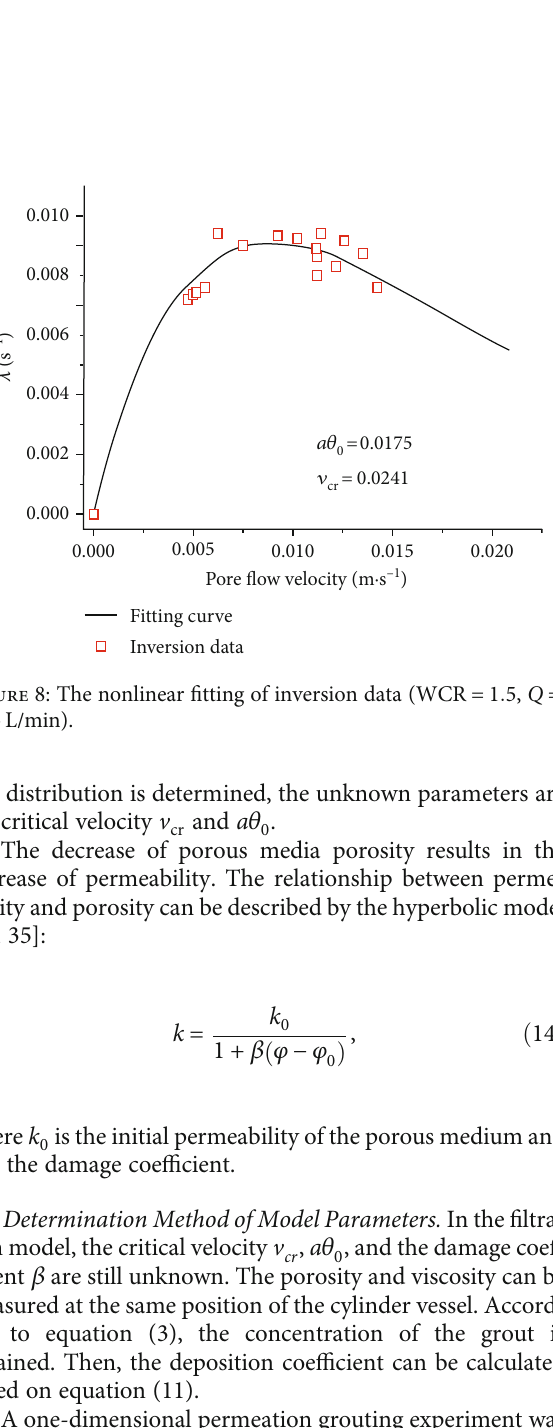
Figure 10: The temporal and spatial variation of grouting pressure(Q =2.85 L/min, WCR =1.5).